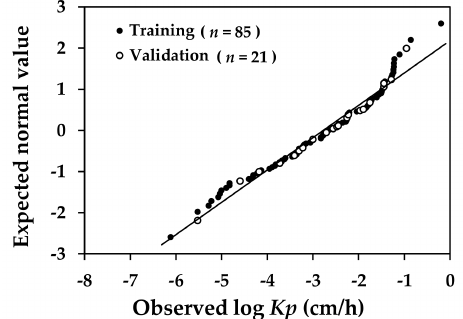
Figure 6. Normal probability plot for logarithmic values of experimentally determined skin permeation coefficient (observed log Kp ) of compounds included in training and validation